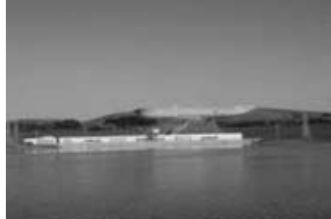
Fig. 4. Kruonis Pumped-storage Hydroelectric Power Plant